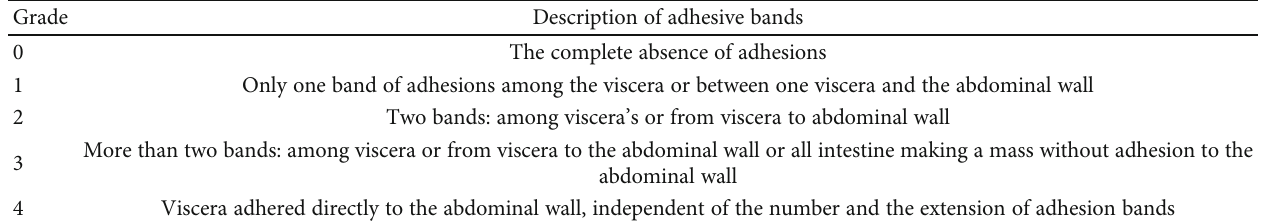
Table 1: Scoring system for peritoneal adhesion according to the Nair et al. criteria [53].